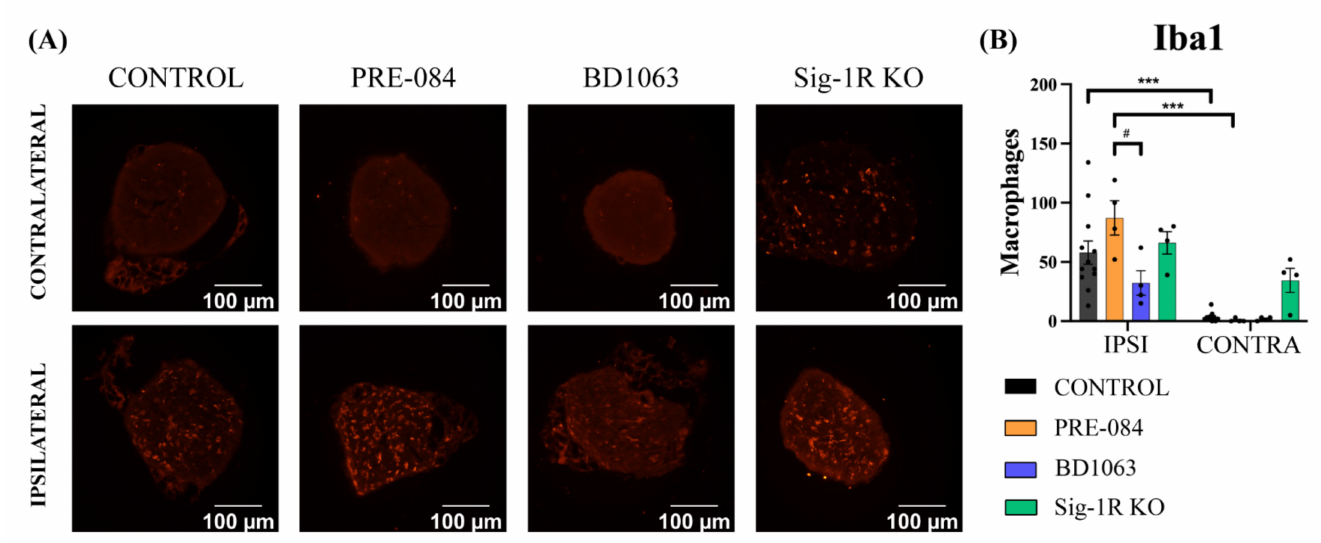
Figure 7. Macrophage infiltration in the regenerated nerve. ( A ) Representative pictures ( × 40) of the IBA1 immunolabeled cells in the regenerated and intact tibial nerves for each group; ( B ) Histograms of macrophage counting of the ipsilateral (IPSI) and contralateral (CONTRA) tibial nerves. Two-way ANOVA and Bonferroni post-hoc test: *** p < 0.001 injured nerve vs. the respective intact contralateral nerve; # p < 0.05 between injured nerve of PRE-084 and BD1063 treated groups (control: n = 12 IPSI, n = 11 CONTRA; rest of the groups: IPSI n = 4 and CONTRA n =